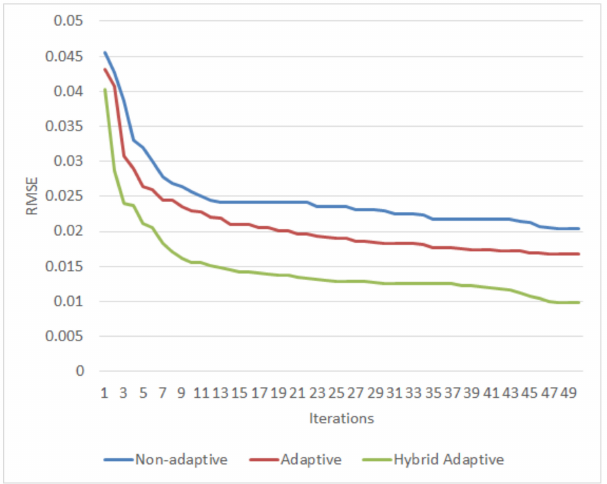
Figure 9. Comparison between the non-adaptive, adaptive, and hybrid adaptive versions of our algorithm. In the adaptive version, adaptive and self-adaptive parameter control strategies were employed. In the hybrid version, the solutions were subjected to backpropagation